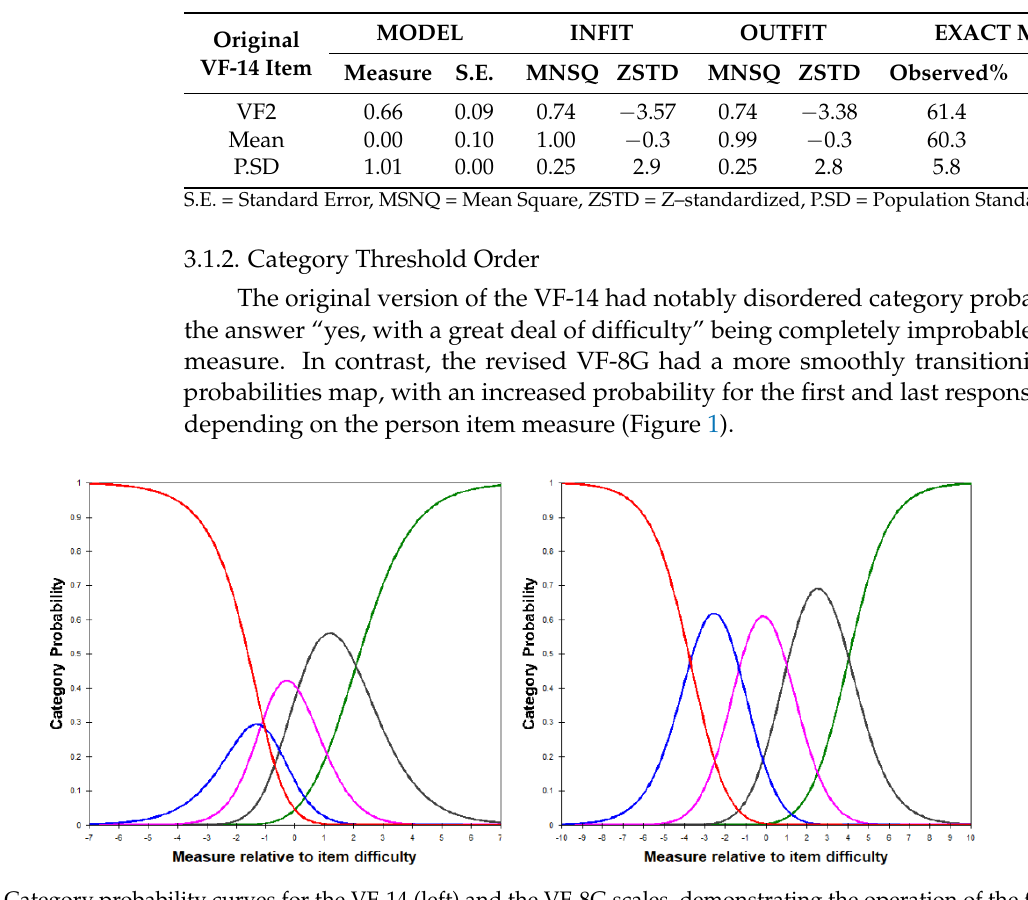
Figure 1. Category probability curves for the VF-14 (left) and the VF-8G scales, demonstrating the operation of the five-item Likert-style response categories. The VF-14 has clearly disordered thresholds with the second response lacking any range along with the ability score where it is most likely to be chosen over the other responses.